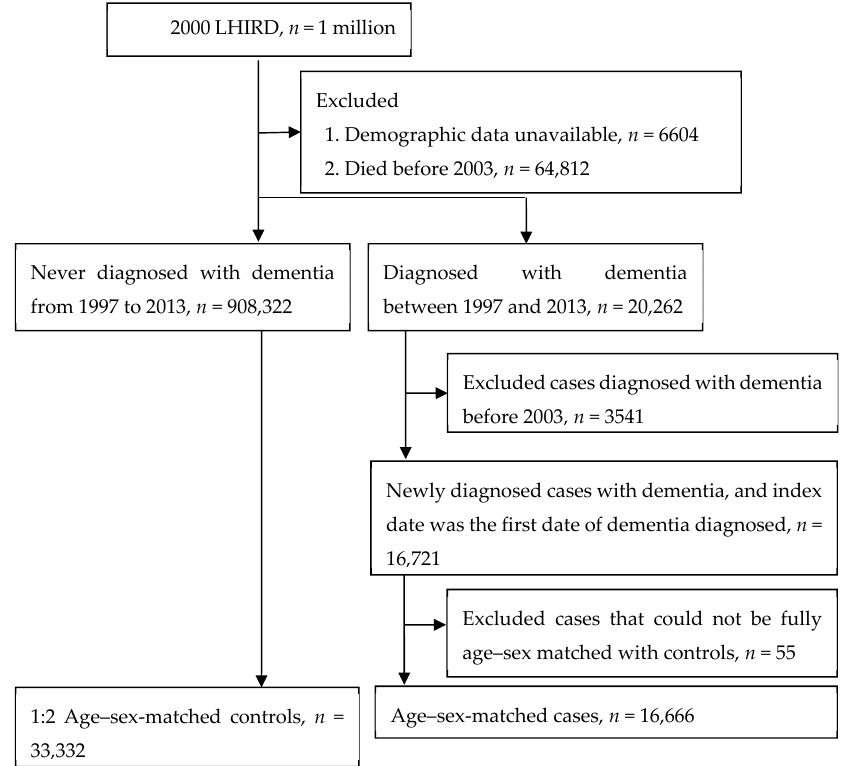
Figure 1. Study design.